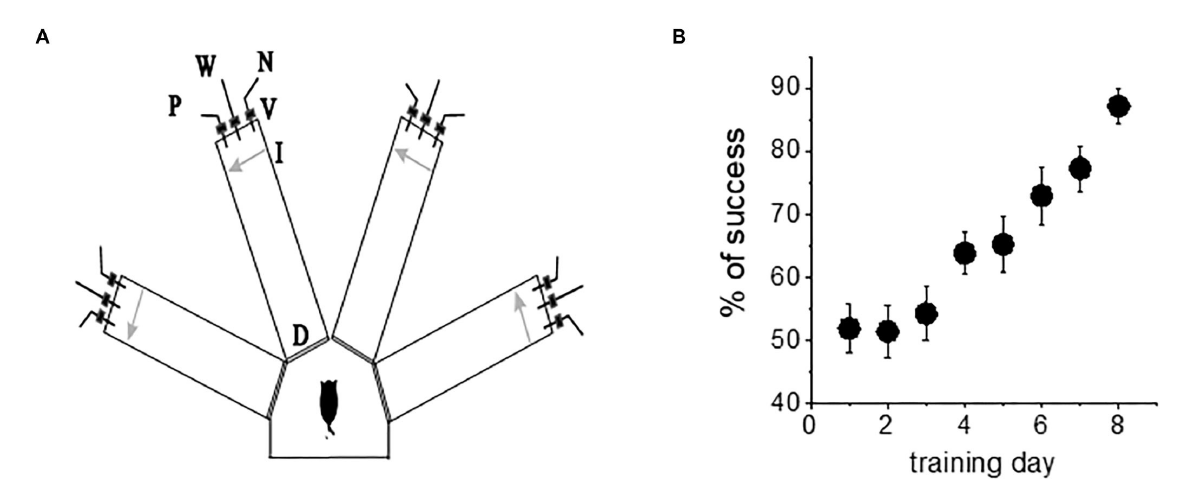
FIGURE1 Complex olfactory learning apparatus and complex OD rule learning. (A) Similar protocols were applied for “trained” and “control” rats. An electronic “start” command randomly opens two of eight valves (V), releasing a positive-cue odor (P) into one of the arms and a negative-cue odor (N) into another. After 8s, the two corresponding guillotine doors (D) are lifted to allow the rat to enter the selected arms. Upon reaching the far end of an arm (90cm long), the rat body interrupts an infrared beam (I, arrow) and a drop of drinking water is released from a water hose (W) into small drinking well (for a “trained” rat—only if the arm contains the positive-cue odor, for “pseudo-trained” rat—randomly). A trial ends when the rat interrupts a beam, or in 10s, if no beam is interrupted. A fan is operated for 15s between trials, to remove odors. (B) Trained rats ( n = 20) demonstrate acquisition of rule learning. With 20 trials per day, 8 consecutive days of training was required for this group to reach the criterion for discriminating between the first pair of odors (80% correct choices). Other groups usually require a similar period. Values represent mean ±